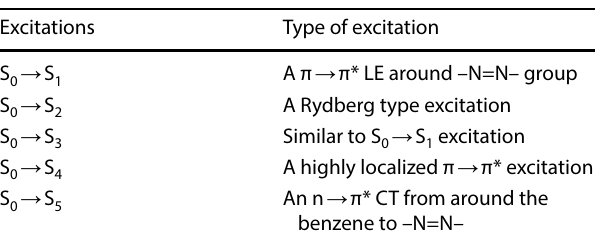
Table 3 Summary of the different types and regions of excitations from the hole and electron analysis of cyanurated H-acid with ani- line (CHA) using RB3LYP method with 6-31G (d,p)